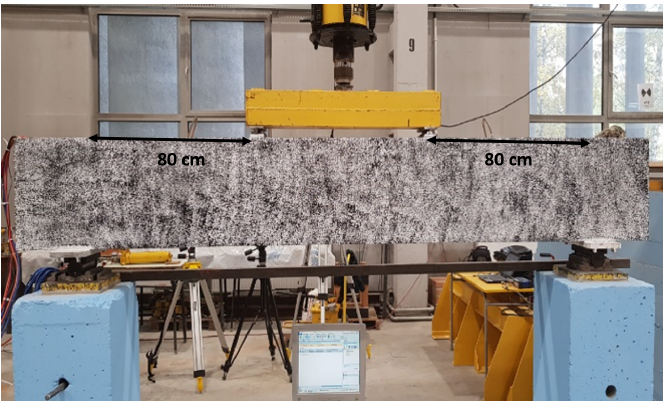
Figure 1. Measuring stand and beam load